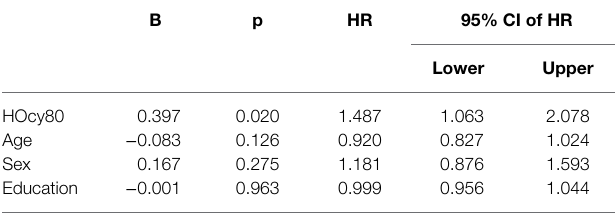
TABLE 6 | Cox proportional hazard model.